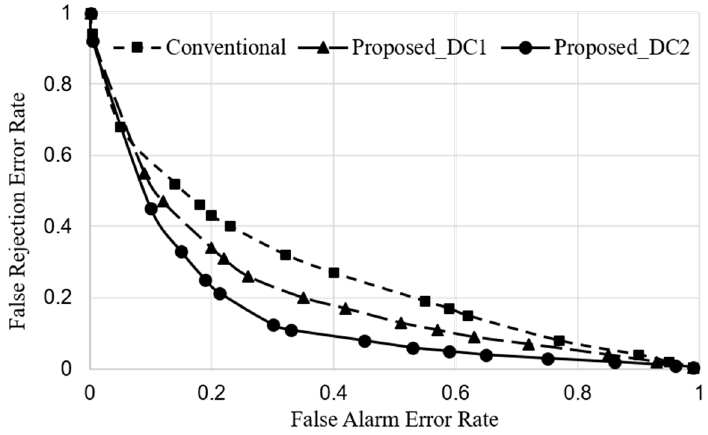
Figure 13. Trigger word detection performance in terms of DET curve.